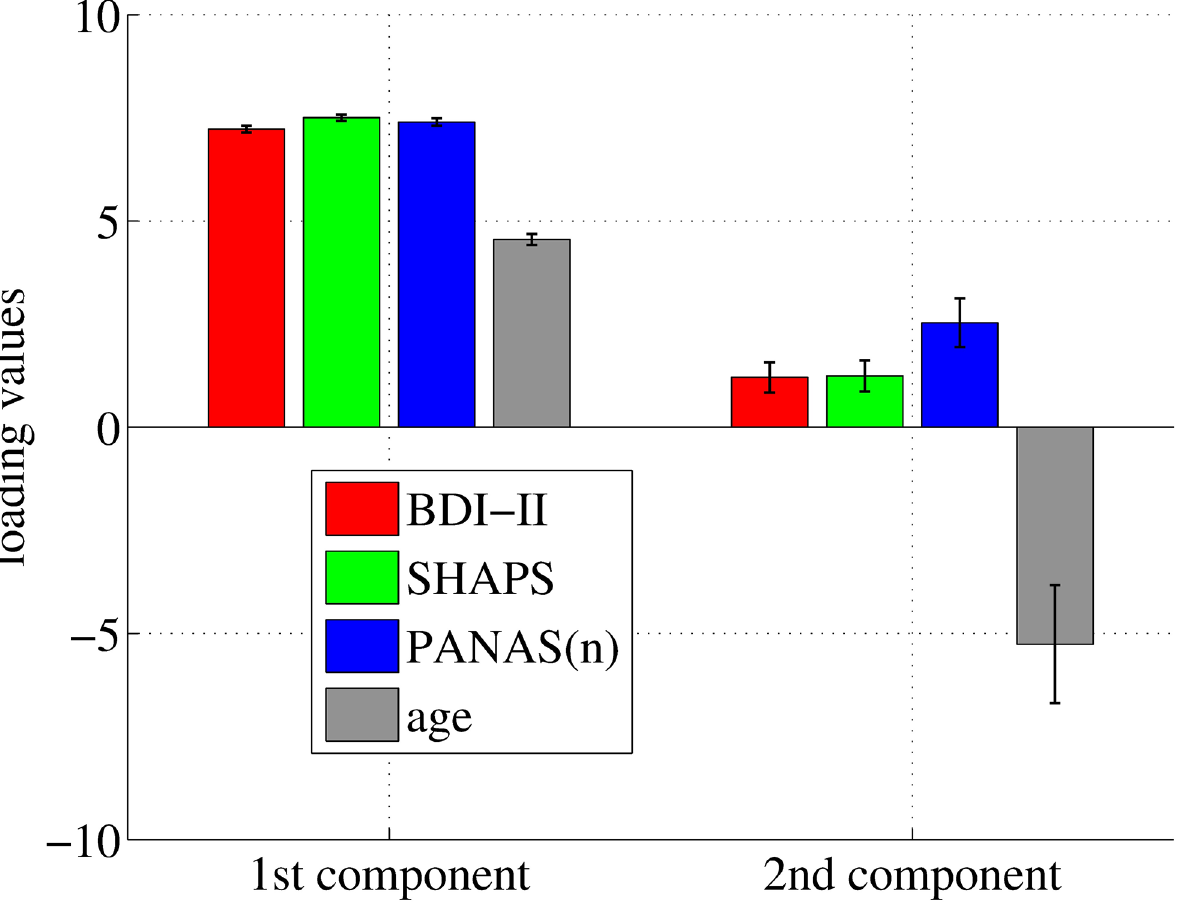
Fig 6. Loading matrix C . The matrix indicatescontributionsof each clinicalmeasure to the first two latent components. Age has a negative influenceon the second latent component.Error bars indicate the standard